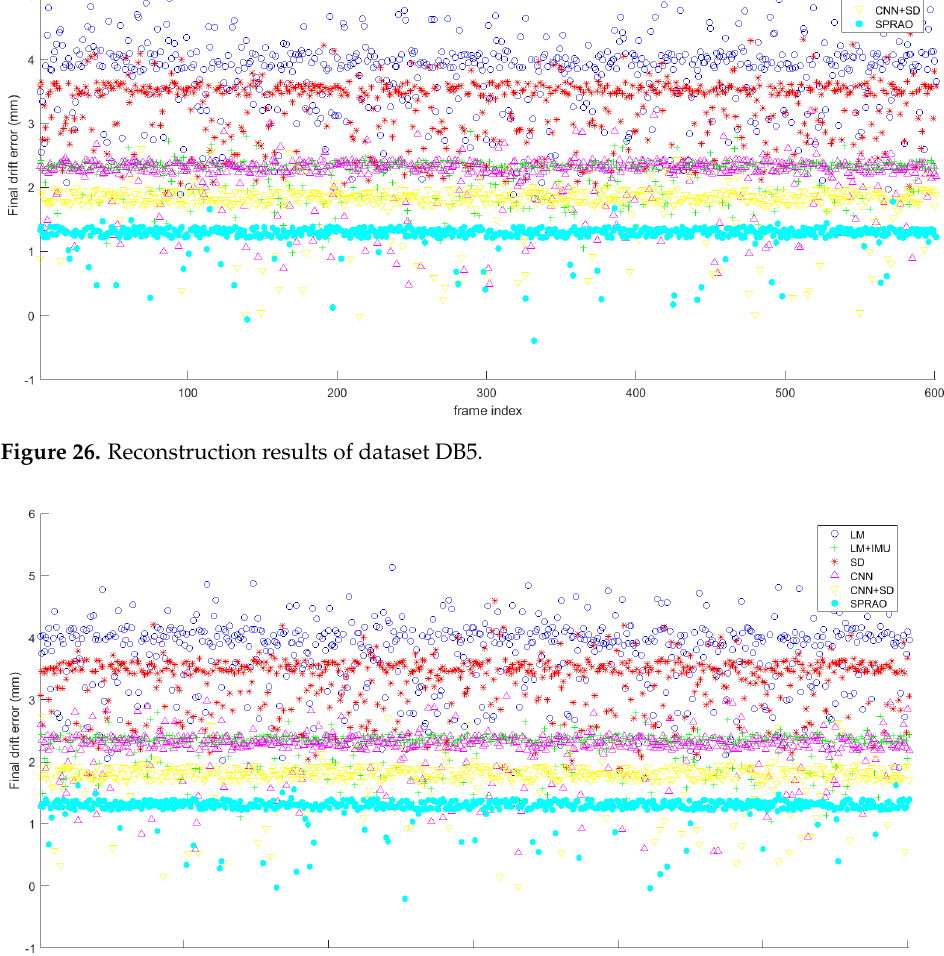
Figure 27. Reconstruction results of dataset DB6.